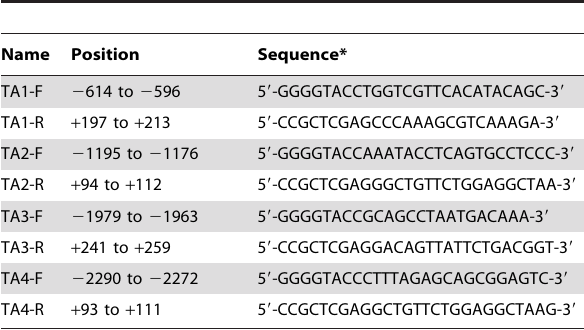
Table 2. Sequences and positions of primers used for cloning the bovine PLCz promoter